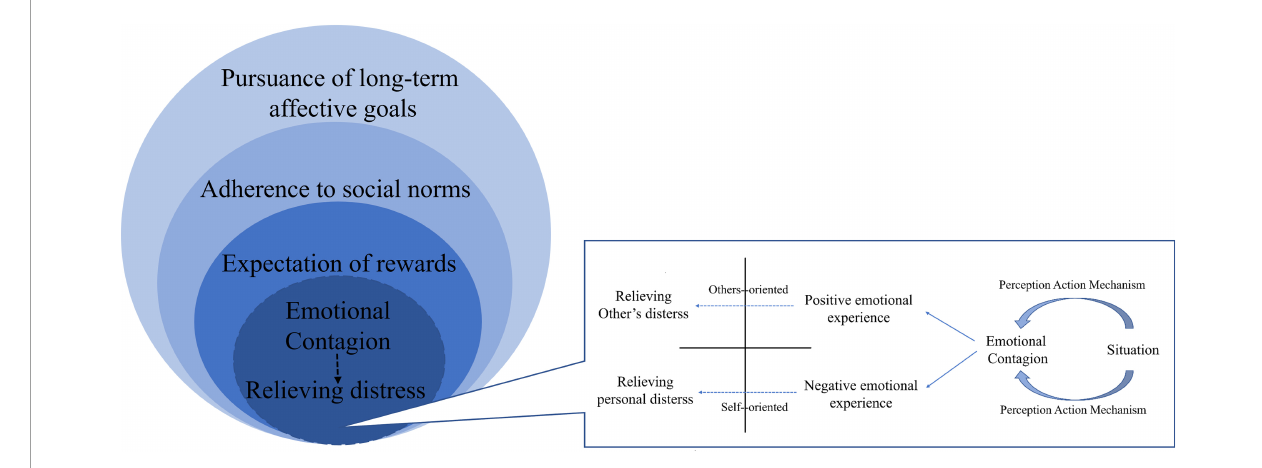
FIGURE4 The circle-layered model of motivation for helping behavior. This figure illustrates the circle-layered model of motivation for helping behavior. According to this model, at the core of helping behavior is the emotional contagion mediated by the perception-action mechanism, which allows individuals to perceive and understand the emotional state of the individual in need of help. This mechanism leads to two different emotional experiences, empathic attention to others or personal distress in oneself, which can motivate individuals to help alleviate their own distress or that of others. The second-layer motivation for helping behavior is the expectation of rewards, which includes both extrinsic and intrinsic rewards. Extrinsic rewards can include social interaction, material rewards, or praises, while intrinsic rewards can include the positive experiences and sense of pleasure generated by helping others. These rewards not only act as positive outcomes of helping behavior but can also be transformed into a motivation for helping behavior. The third and fourth layers of motivation for helping behavior are mediated by the more advanced affective-cognitive system. These layers include abiding by social norms and pursuing long-term affective goals, such as pride and a sense of meaning. Overall, this model suggests that the motivation of helping behavior may evolve and develop from the emotional-behavioral system to the affective-cognitive system, and from the inner layer to the outer layer, which is likely shared by humans and non-human